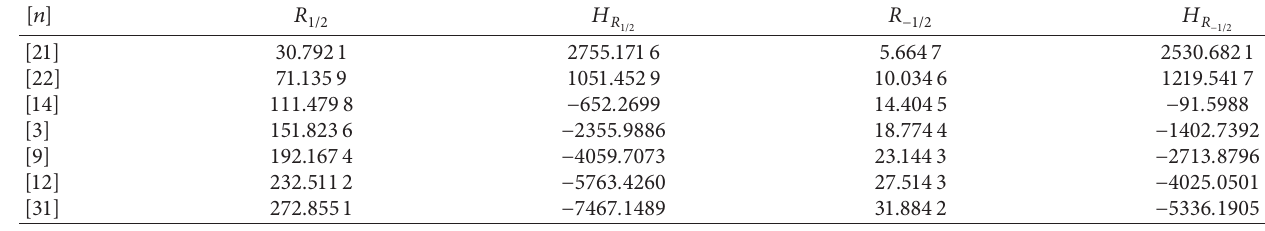
and R − with their respective heat formation for GST − SL [ n ] 1/2 1/2